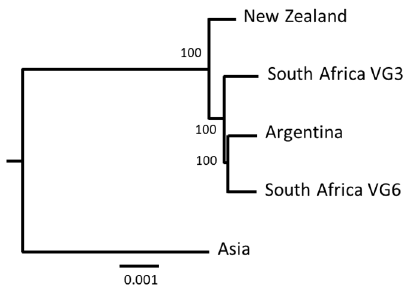
Figure 4. Maximum likelihood tree of five mitochondrial genomes of Vespula germanica based on an alignment of 13 mitochondrial protein-coding genes. Values above the branches represent bootstrap nodal support.